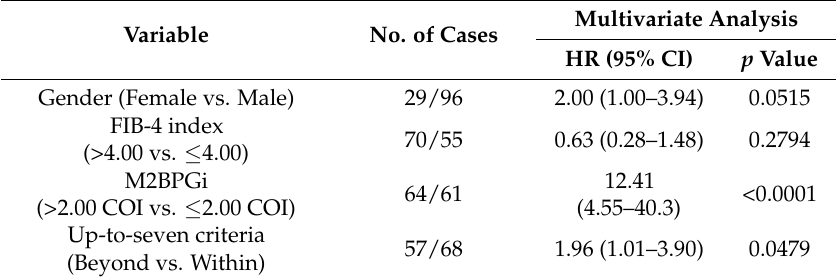
Table 3. Multivariate analysis of the factors associated with Child-Pugh grade deterioration from A to B among patients who underwent transarterial